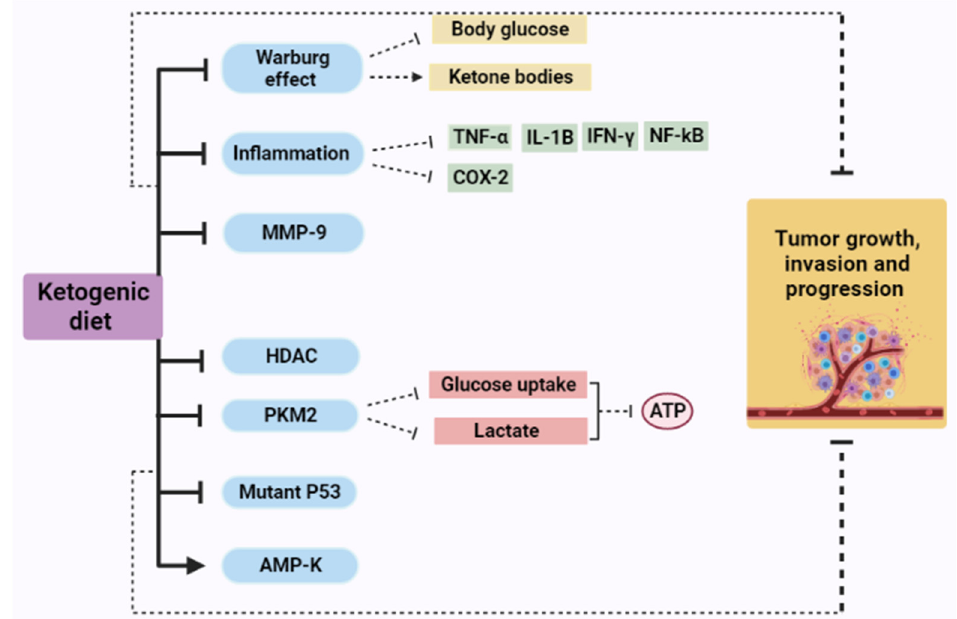
Figure 2. Ketogenic diet mechanism of action as a cancer therapy, ( → ), activation; ( ┬ ), inhibition; MMP-9, matrix metalloproteinases-9; TNF- α , tumor necrosis factor alpha; HDAC, histone deacetylases; PKM2, pyruvate kinase M2; AMP-K, AMP-activated protein kinase; IL-1B, interleukin 1 beta; IF- γ , interferon gamma; NF-kB, nuclear factor kappa B.